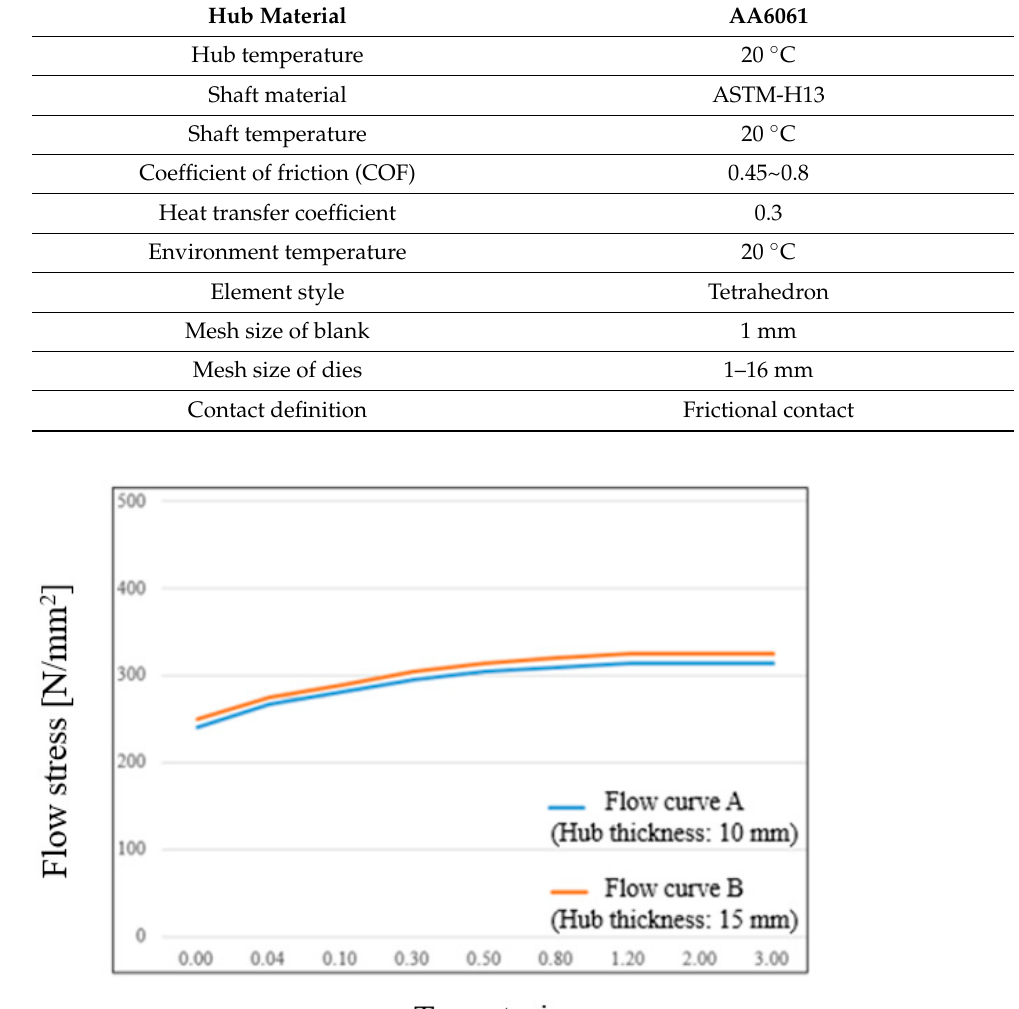
Figure 2. Flow curves of the different hub thicknesses for AA 6061 . Table 3. The parameters of the forging process.